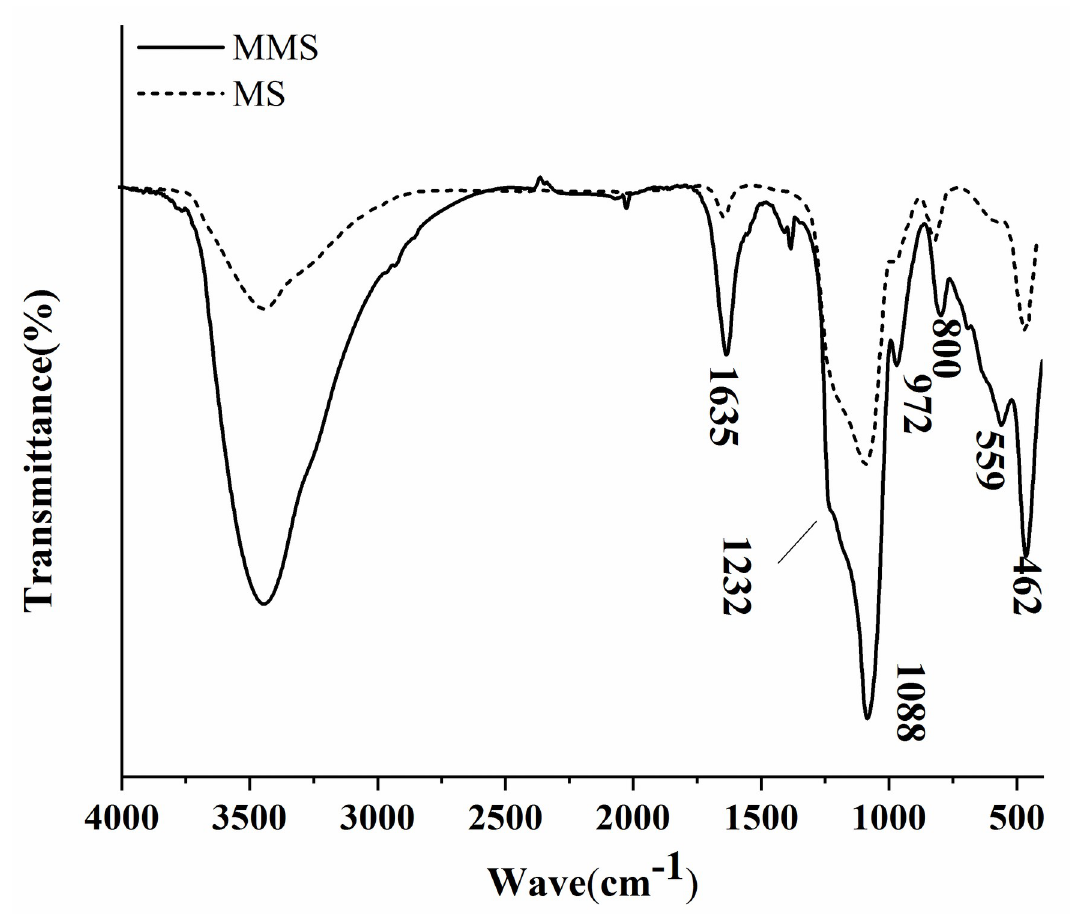
Fig 2. Infrared spectrum of MS and